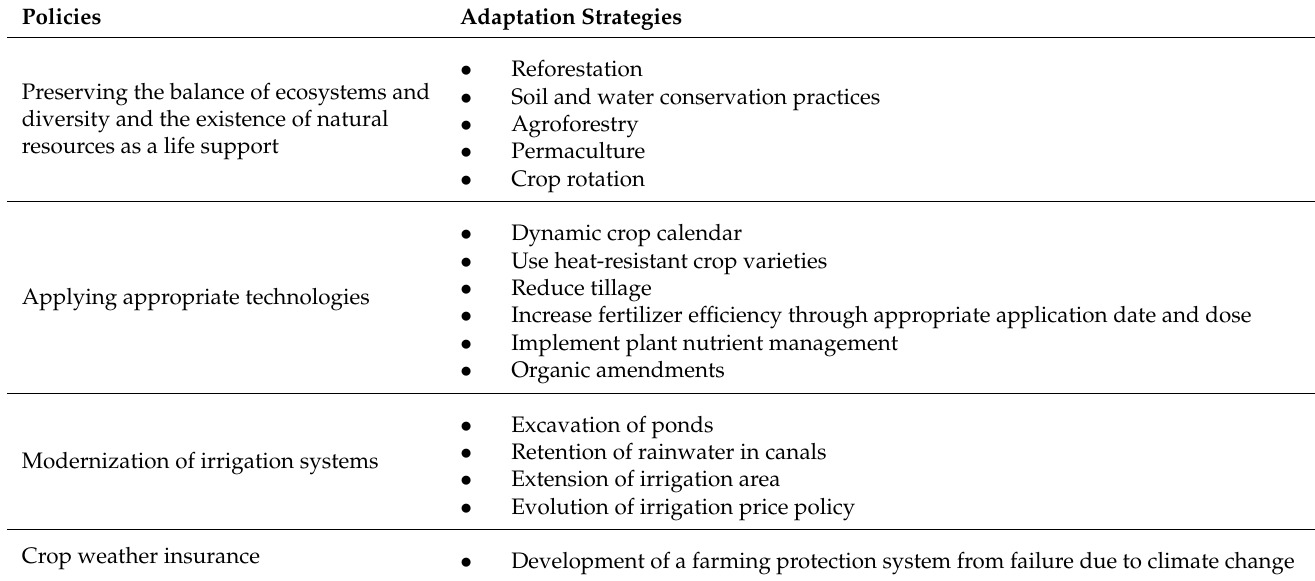
Table 4. Recommended policies and adaptation